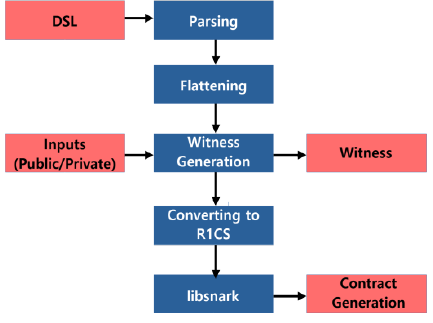
Figure 4: Zokrates Components